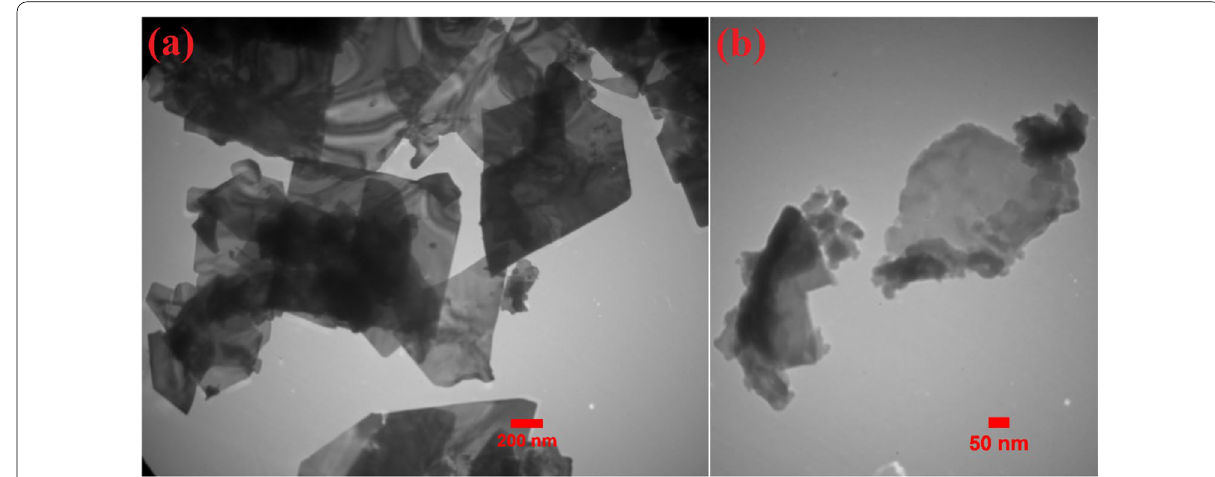
Fig. 5 TEM images of Bi 2 O 3 /Bi 2 O 2 CO 3 /(BiO) 4 CO 3 (OH) 2 nanoflakes with different magnifications, a 200 nm and b 50 nm